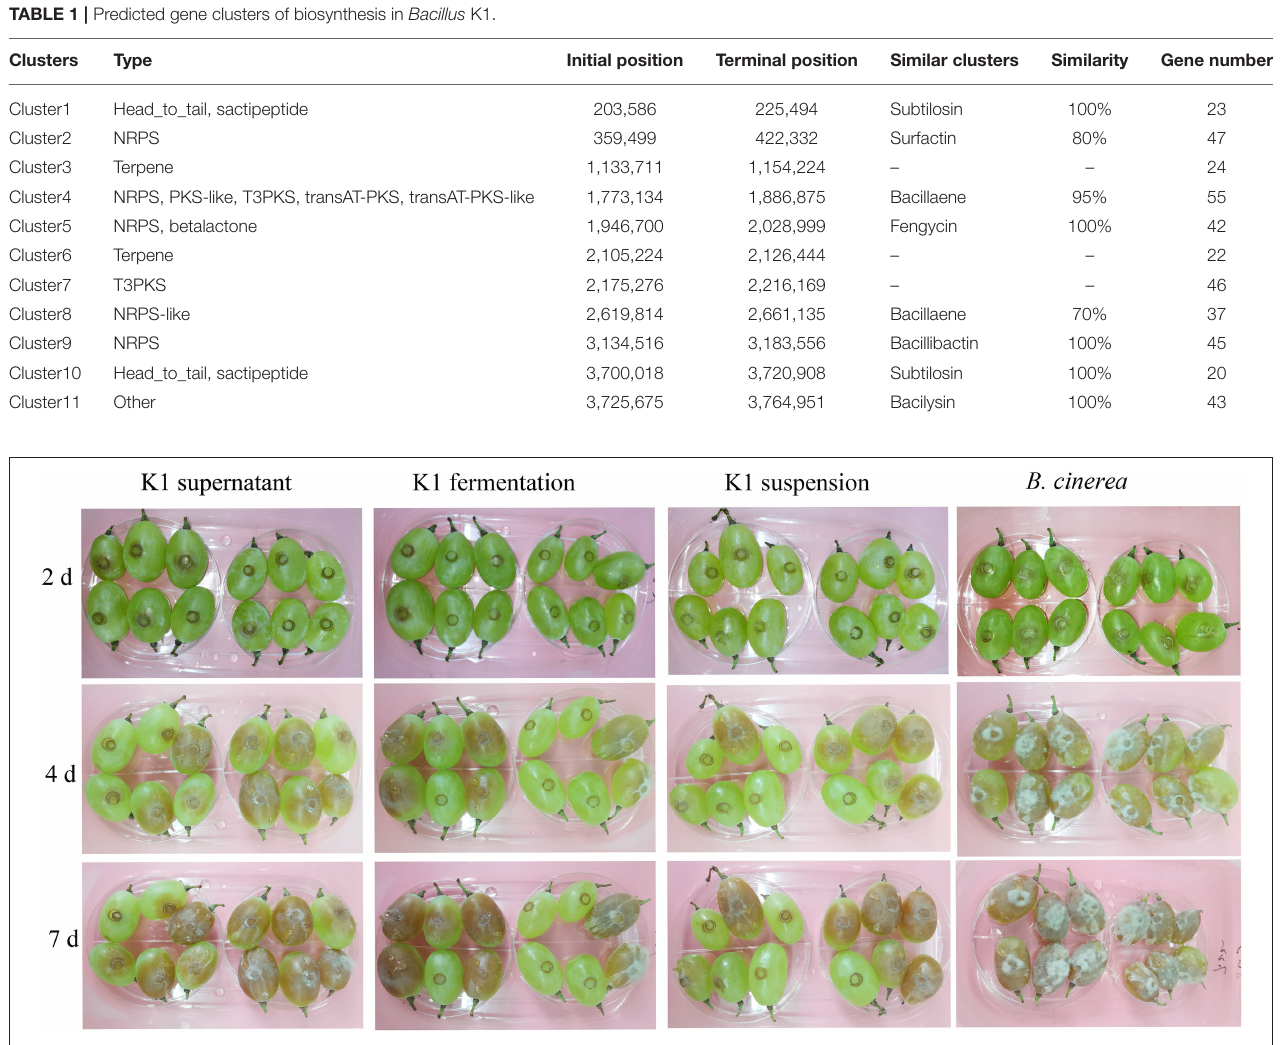
FIGURE 5 | In vivo antifungal effect evaluation of K1 culture on grape fruit. Grapes were inoculated with K1 fermentation broth, supernatant, and suspension, respectively, and subsequently injected B. cinerea conidia suspension at the concentration of 10 6 . Control group were treated with B. cinerea conidia suspension (1 × 10 6 ml − 1